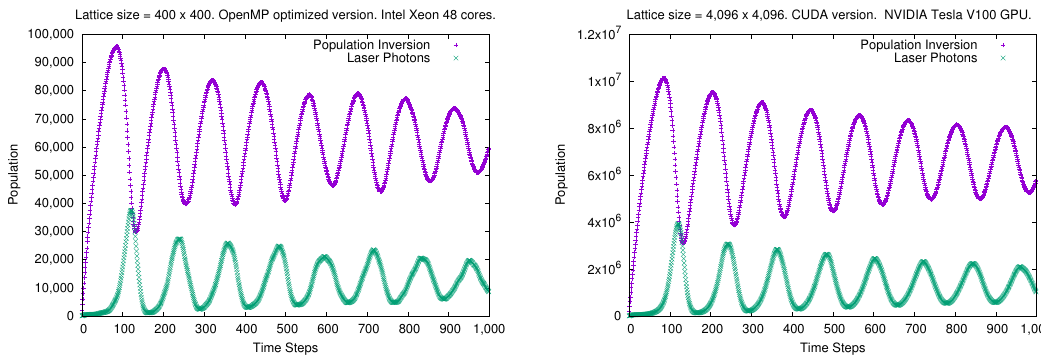
Figure 1. Output of the model for particular values of the system parameters corresponding to a laser spiking behavior. Parameter values: λ = 0.0125, τ c = 10, and τ a = 180. The results are smoother for larger lattice sizes. ( Left ): Parallel OpenMP optimized implementation with a lattice size of 400 × 400 cells. ( Right ): Parallel CUDA implementation with a lattice size of 4096 × 4096